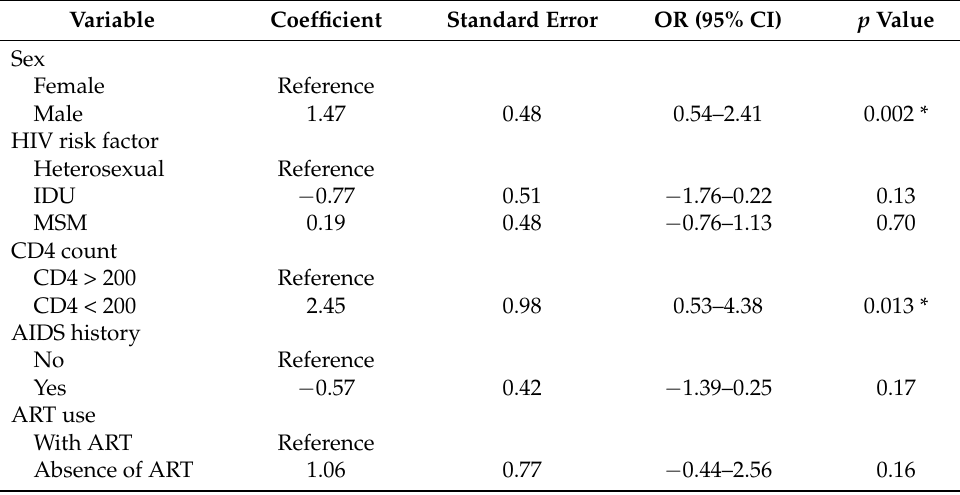
Table 3. Meta-regression analysis of HZ risk factors affecting